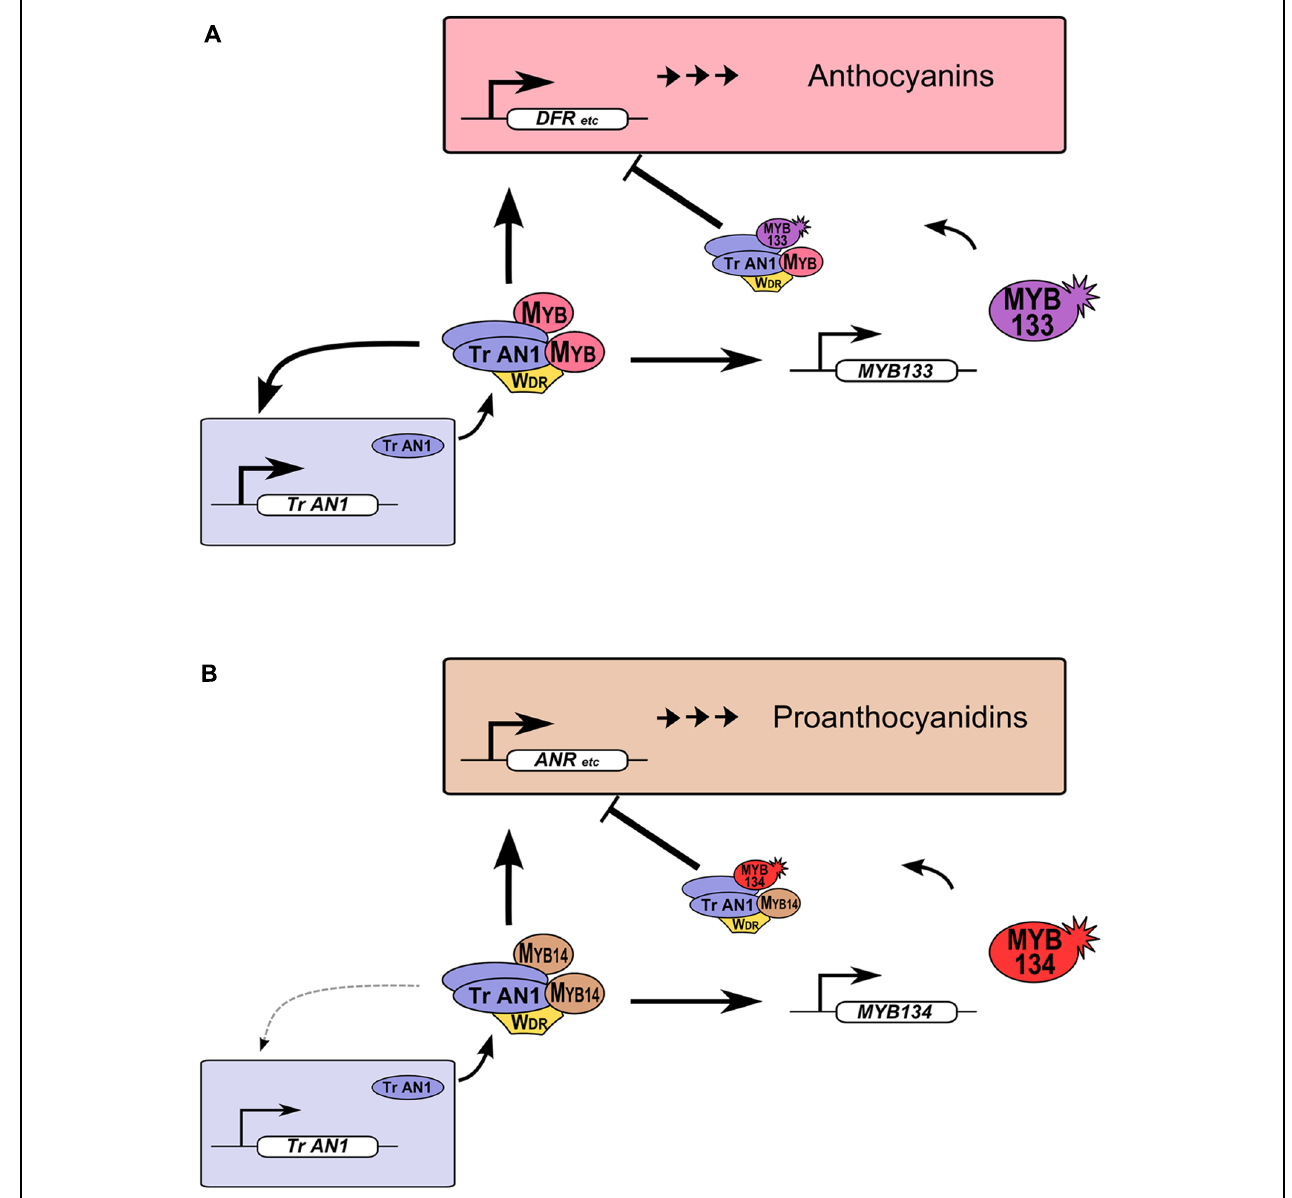
FIGURE 5 | Tr-MYB133 and Tr-MYB134 participate in MBW regulatory networks. (A) Anthocyanin MBW gene regulation network. MBW complexes containing anthocyanin R2R3-MYB activate genes required for anthocyanin biosynthesis and transport, resulting in anthocyanin pigment accumulation.